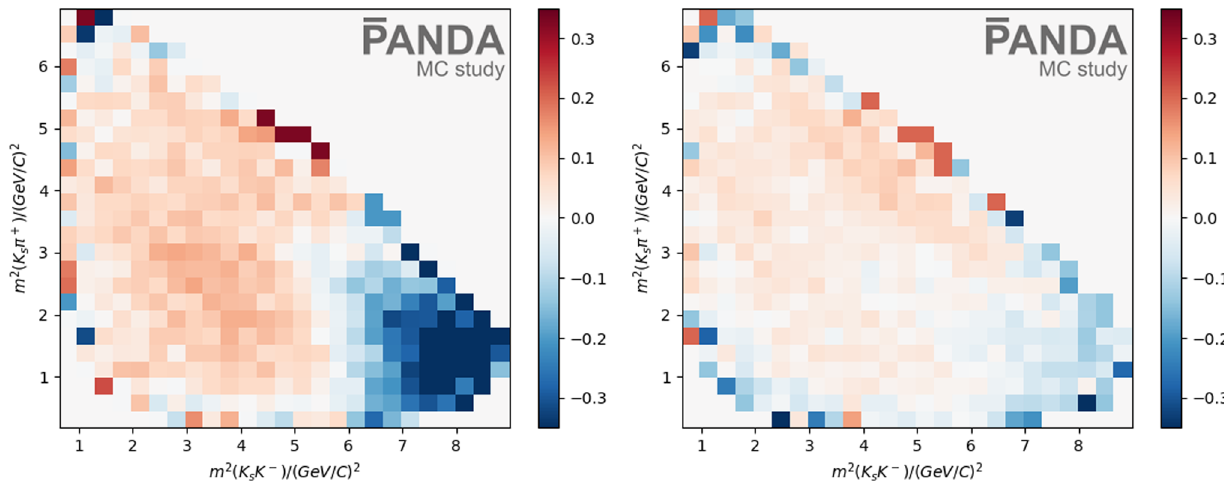
Fig. 9 Trigger efficiency deviation from the mean value in Dalitz coordinates for the channel Etac at 3.8 GeV/ c , without (left) and with (right) the additional